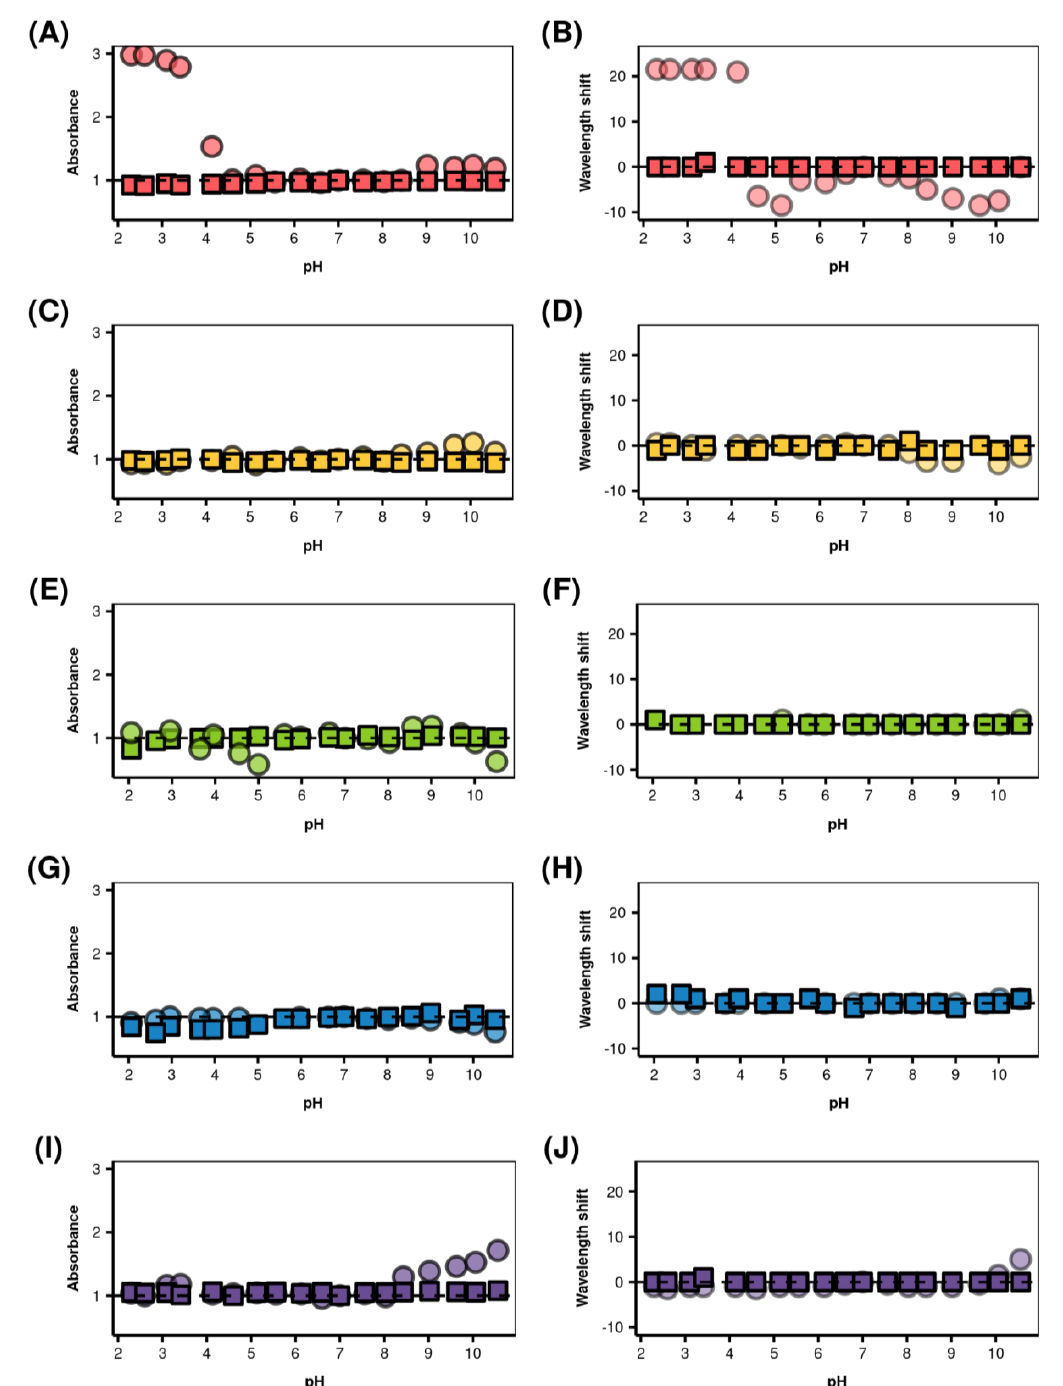
Figure 6. Effect of pH on the UV-vis absorption of ( A ) THPP, ( C ) T(OAc)PP, ( E ) T(MAP)PP, ( G ) T(PrOH)PyP and ( I ) ZnTHPP, as free porphyrins (circles) or as encapsulated poprhyrins (squares). The effect on the Soret band maximum wavelength was also analyzed, for ( B ) THPP, ( D ) T(OAc)PP, ( F ) T(MAP)PP, ( H ) T(PrOH)PyP and ( J ) ZnTHPP, as free porphyrins (circles) or as encapsulated porphyrins (squares). Free porphyrins were dissolved in DMF and diluted in aqueous media to a final concentration of 5 µM and 5% DMF; encapsulated porphyrins were suspended in aqueous media, for a final concentration of 5 µM, of their corresponding porphyrin. Data were normalized, as based on the obtained absorbance and Soret’s band wavelength at pH 7.